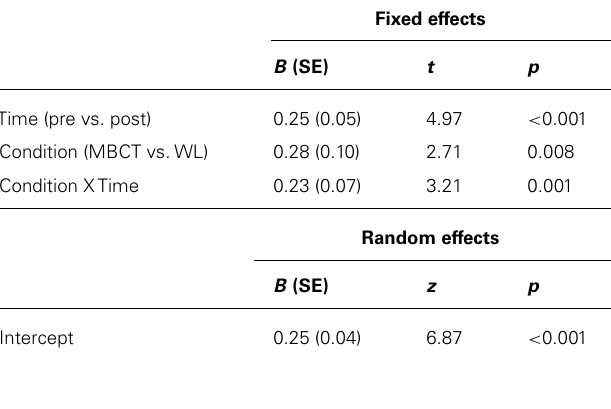
Table 2 | Multilevel regression analysis of the effects of MBCT on momentary experiences of positive